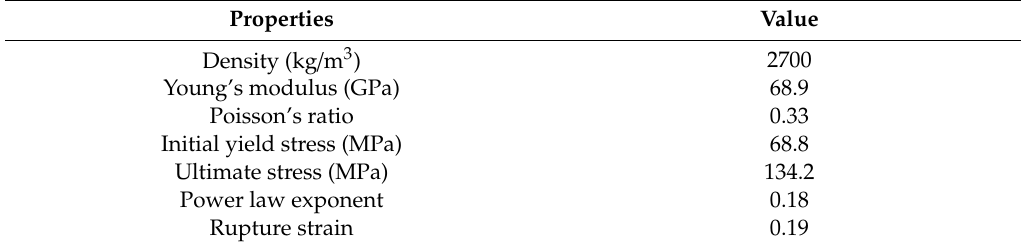
Table 2. Mechanical properties of aluminum alloy AA6061-O.